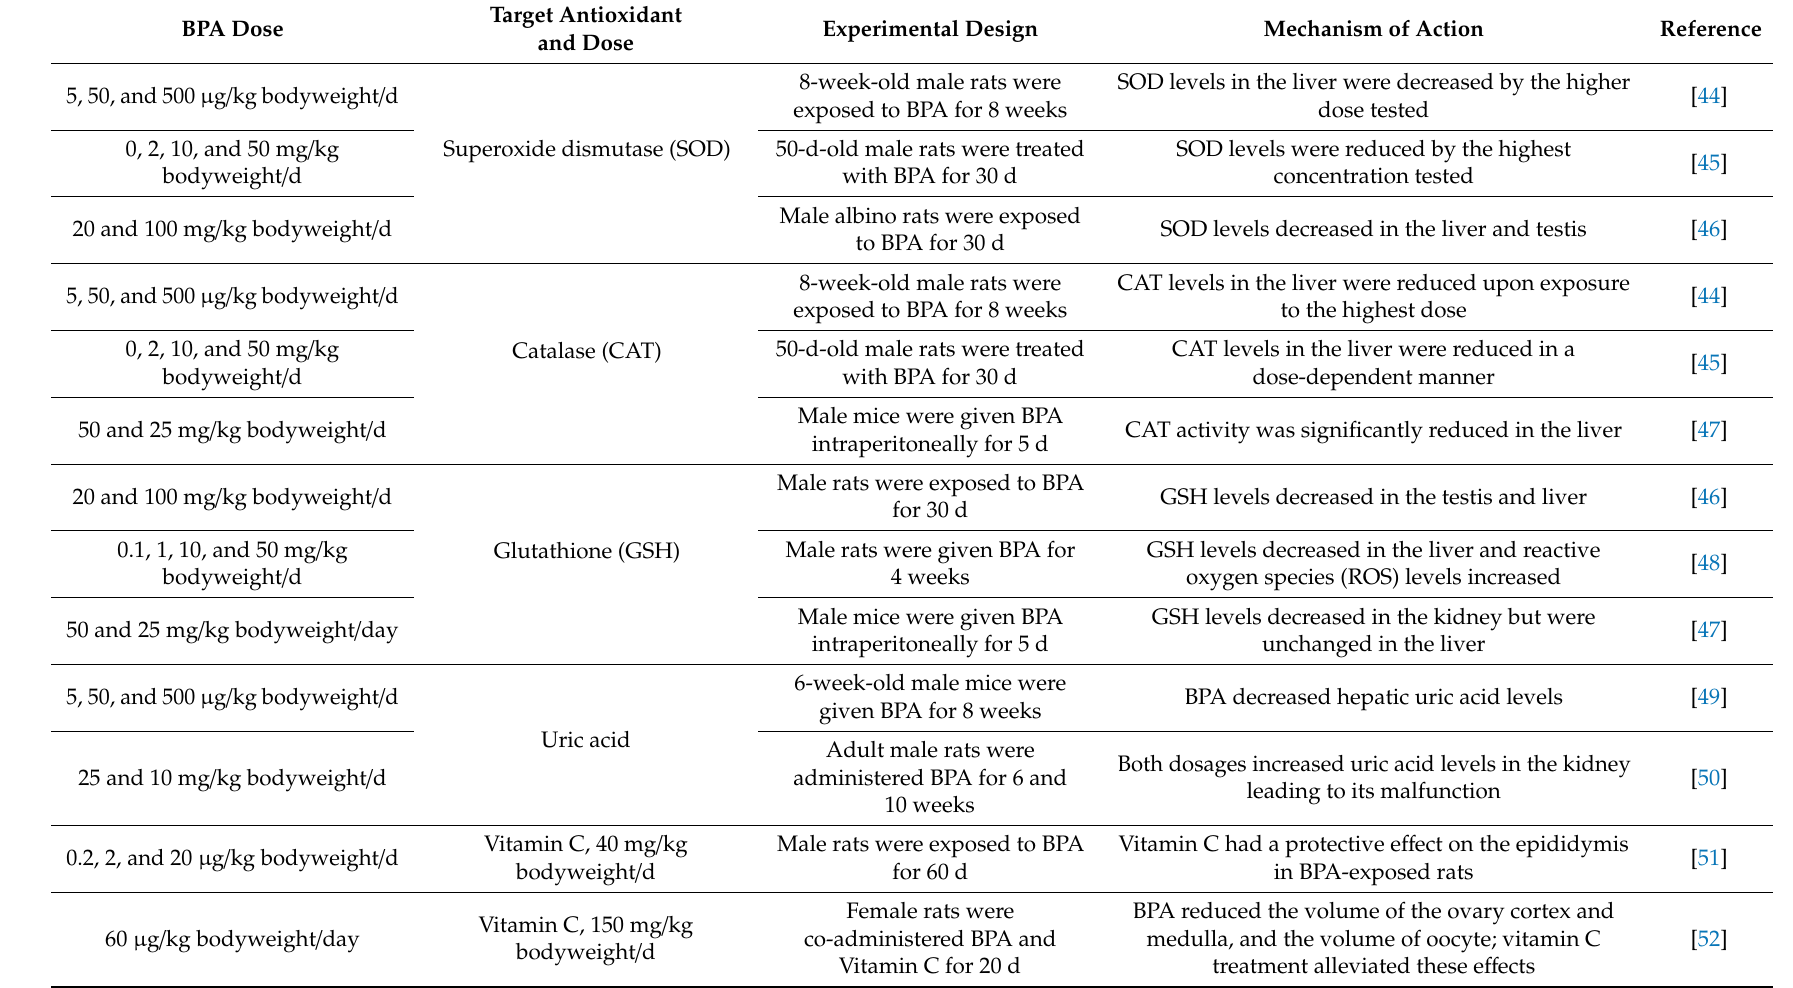
Table 1. Summary of the antioxidant e ff ects alleviating bisphenol A (BPA) toxicity: evidence from in vivo